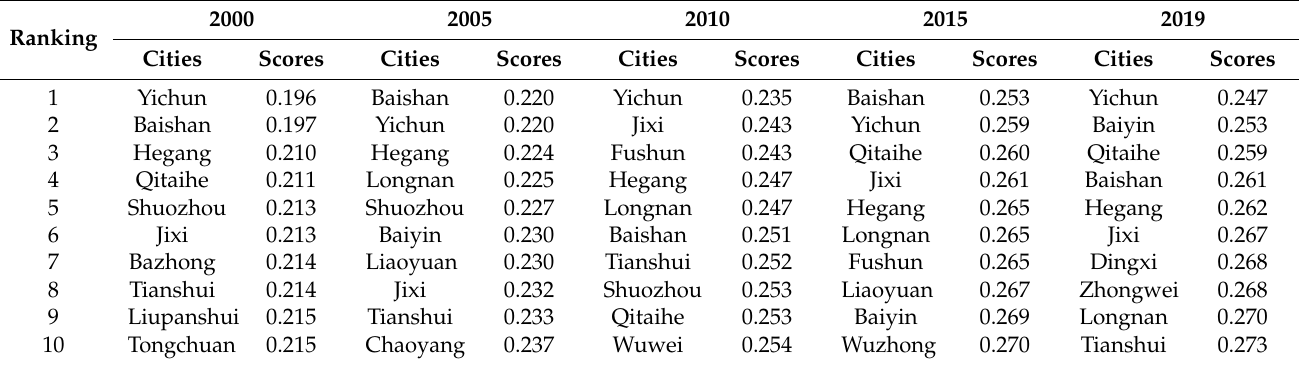
Table 3. The bottom ten cities in China’s urban human settlements development level and their scores.